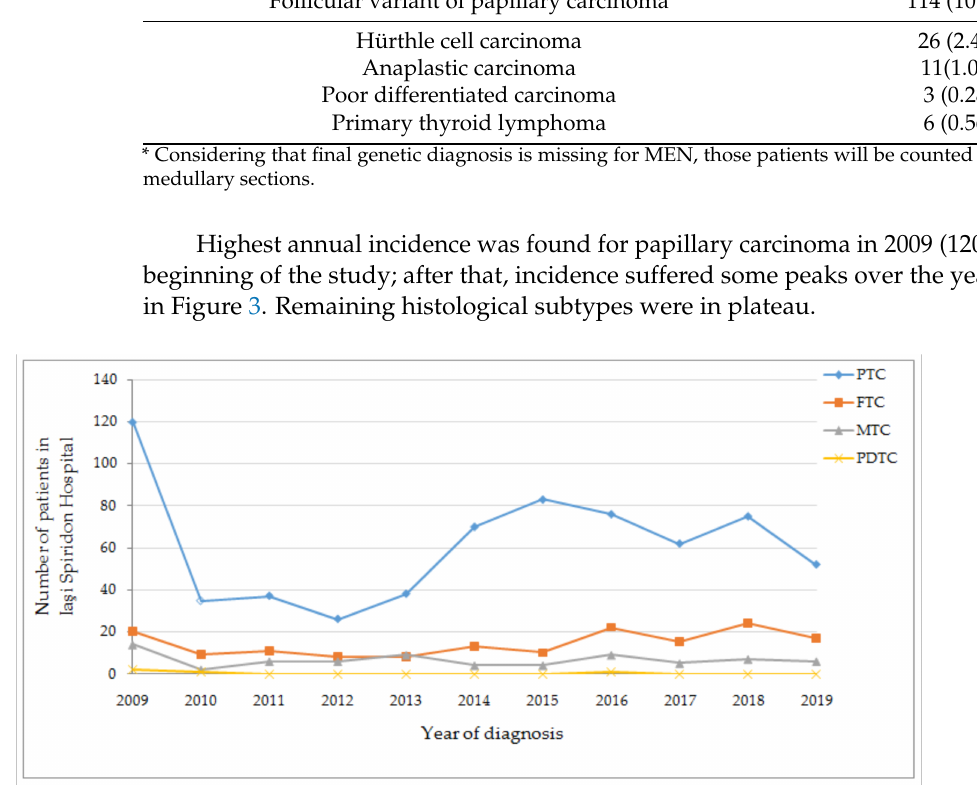
Figure 3. Thyroid carcinoma’s histopathological picture of the North East region (2009–2019), PTC—papillary thyroid carcinoma, FTC—follicular thyroid carcinoma, MTC—medullary thyroid carcinoma, PDTC—poorly differentiated thy- roid